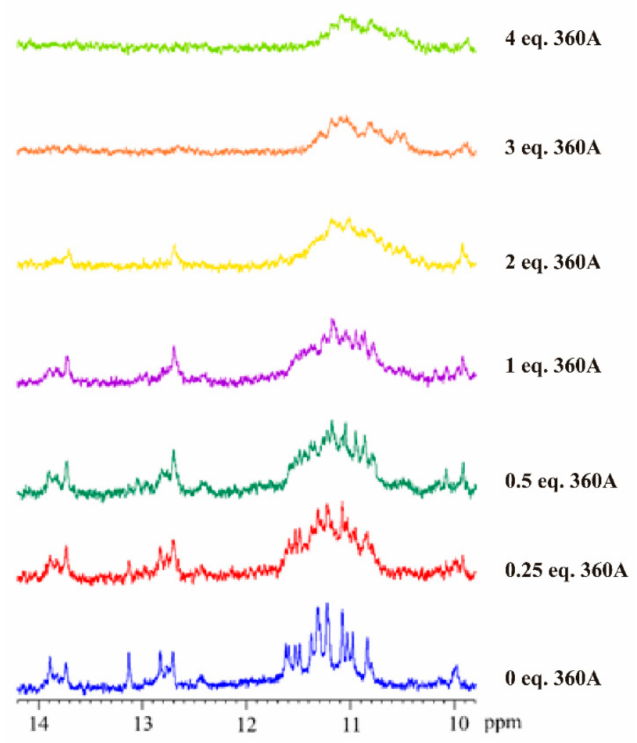
Figure 10. 1 H NMR spectra showing the imino region of AS1411-N6 upon 360A titration. The spectra were recorded in 90% H 2 O, 10% D 2 O at 25 ◦